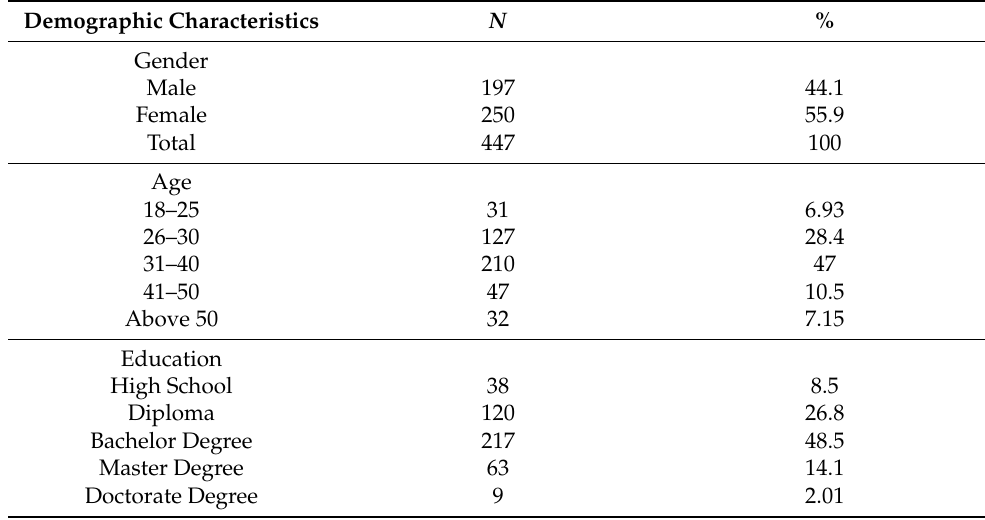
Table 1. Respondents’ demographic